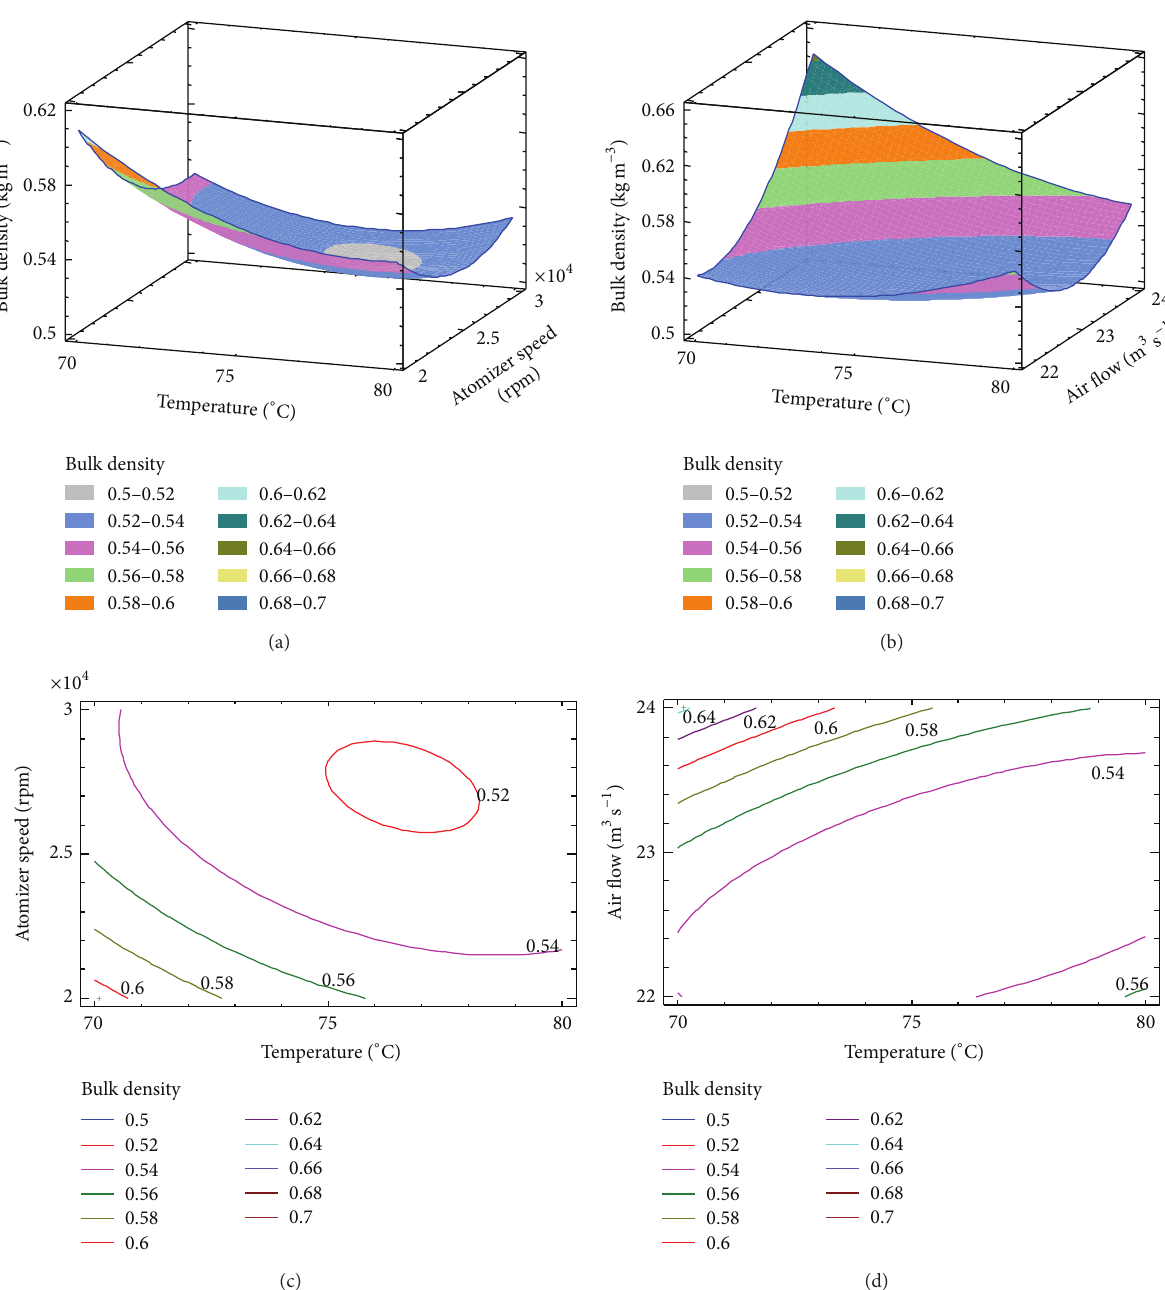
Figure 3: Surface plot showing (a) the effect of temperature and atomizer speed at an air flow of 0.215 m 3 s −1 and (b) the effect of temperature and air flow at an atomizer speed of 25000 rpm on the bulk